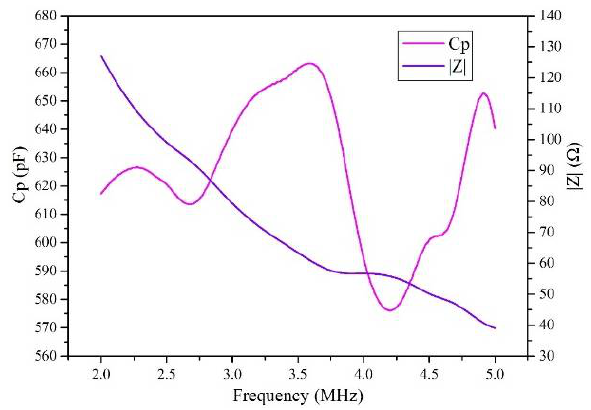
Figure 3. Frequency property of the PMUT.